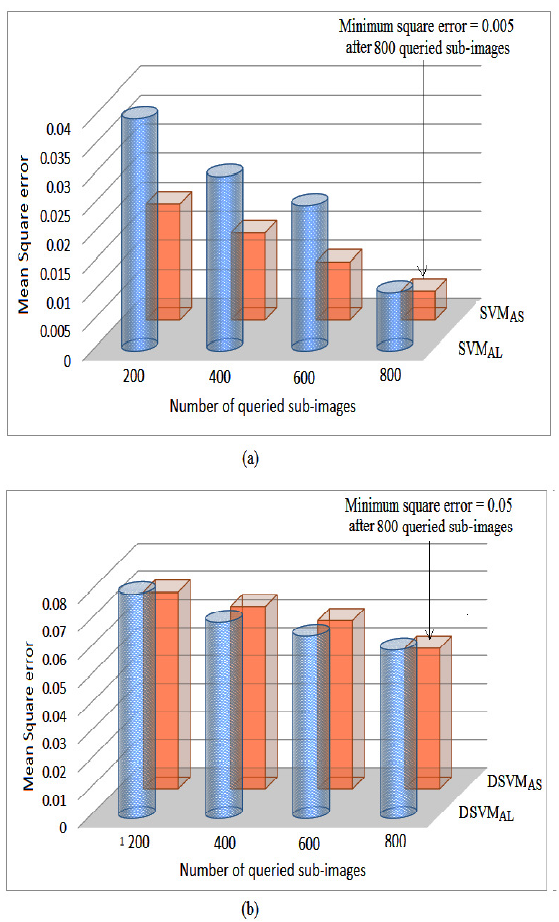
Figure 16. The mean square error over the number of queries when performing learning on the 512 × 512 resolution scenes. ( a ) SVM AS and SVM AL ( b ) DSVM AS and DSVM AL